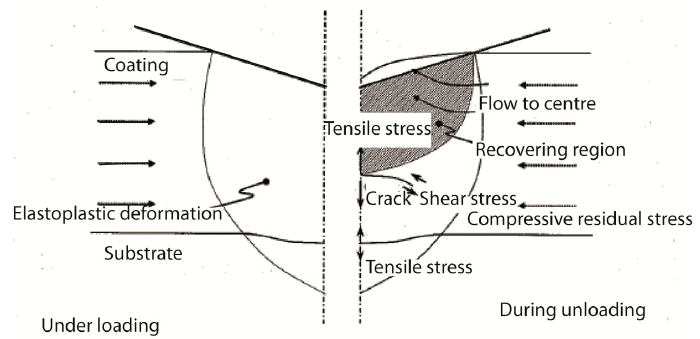
Figure 19. Model for coating fracture mechanism during indentation [44].